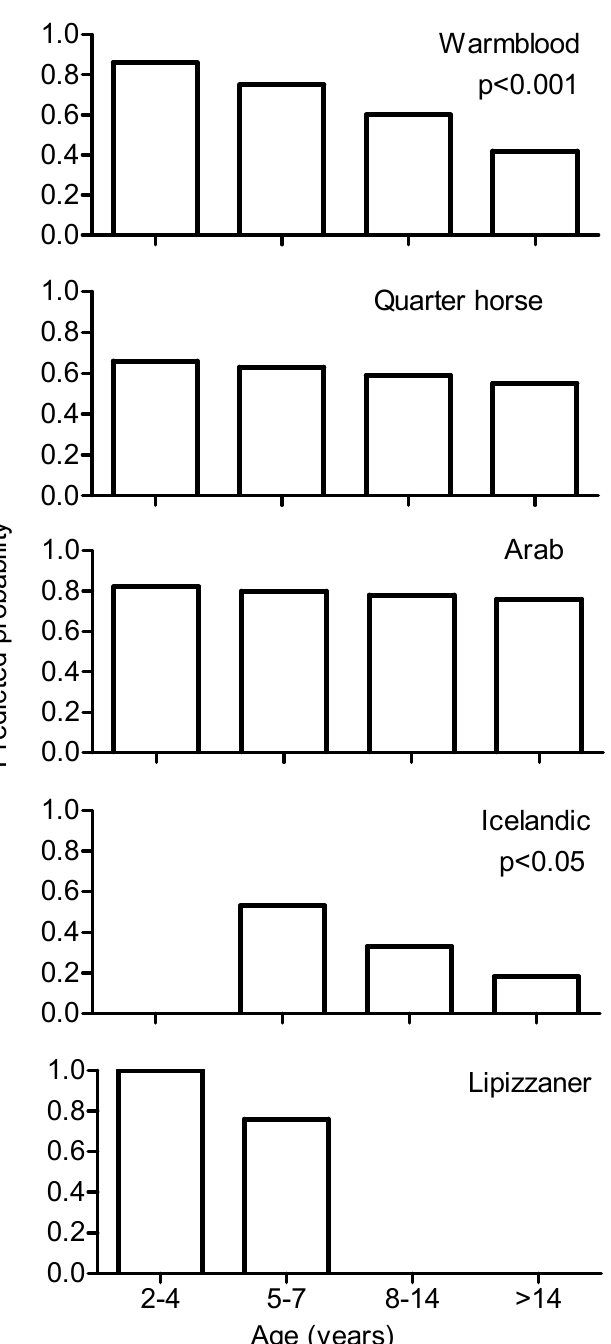
Figure 1. Aggregated probability for acceptable cryopreserved ejaculates (progressive motility after freezing-thawing ≥ 35%) determined by logistic regression analysis for breed and age of stallion, decrease with age in Warmblood ( p < 0.001) and Icelandic stallions ( p < 0.05).